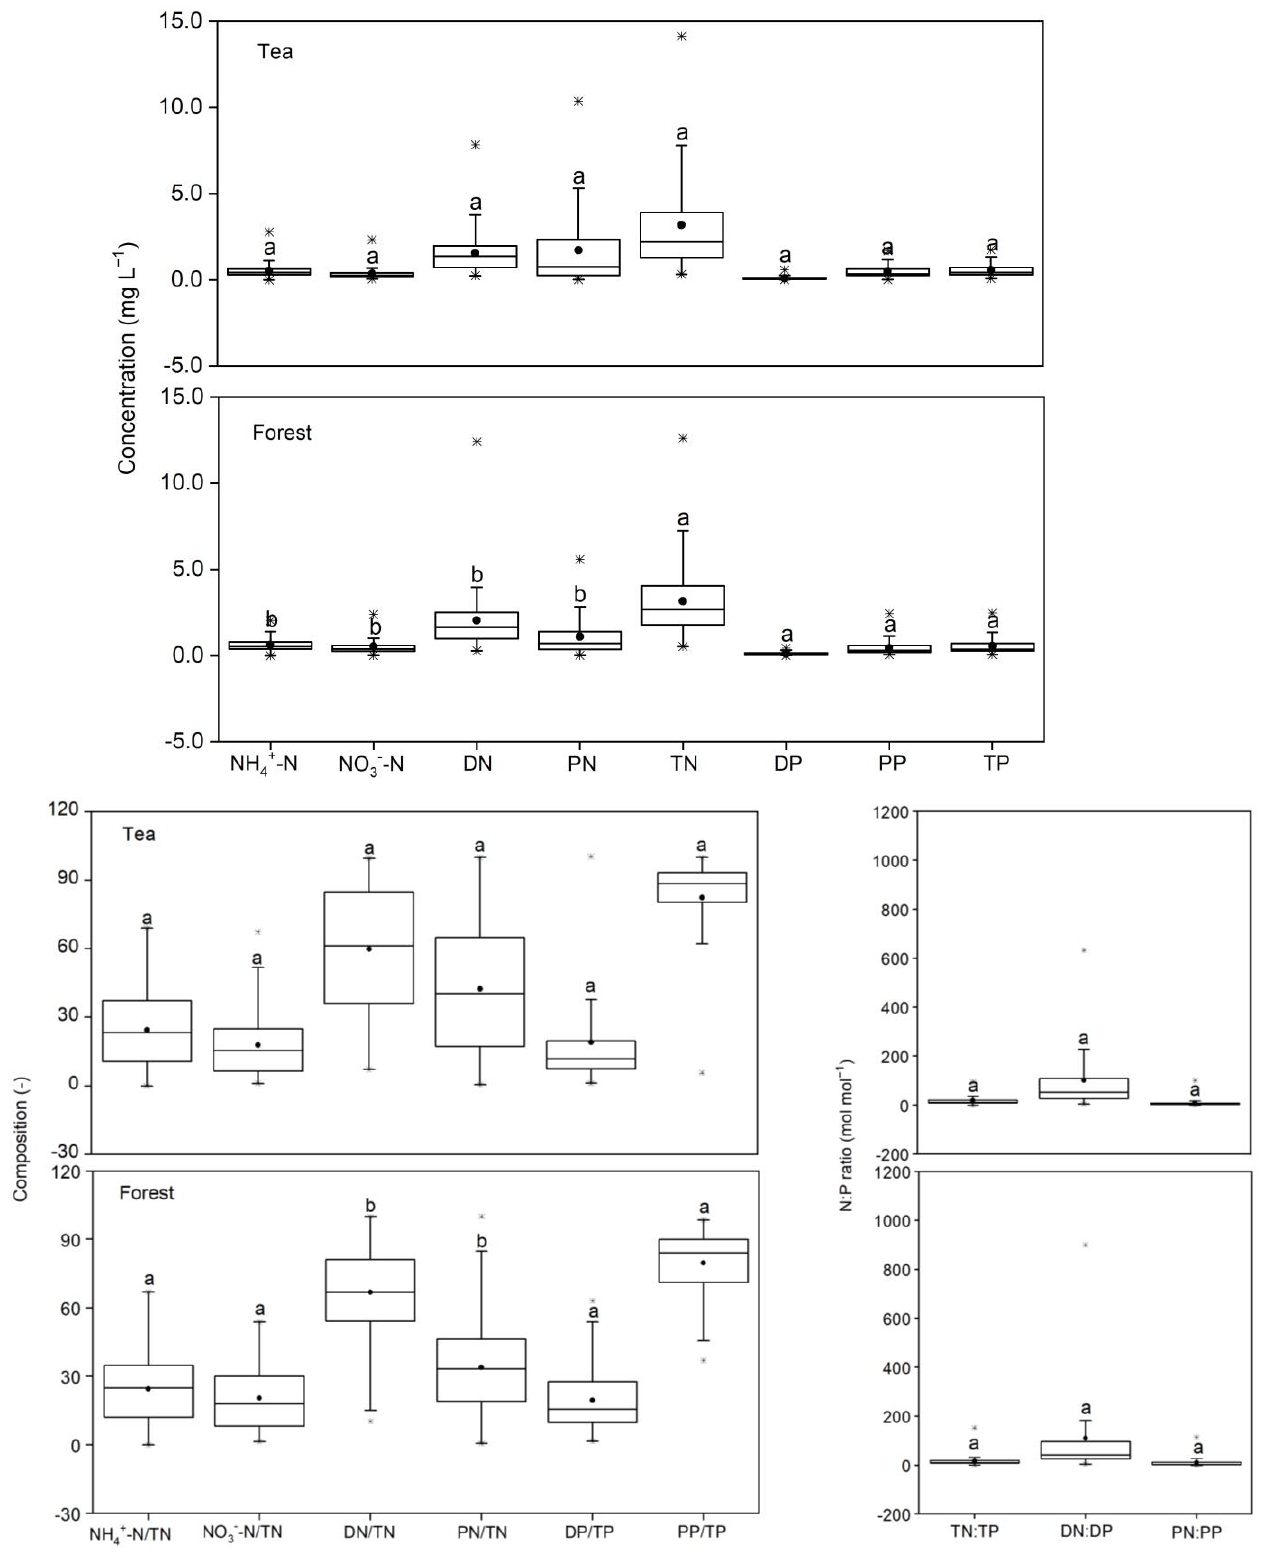
Figure 3. Mean and standard deviation (SD) of the nitrogen and phosphorus concentrations, chemical compositions, and molar ratios in the surface runoff in the tea and forest systems. Different letters indicate a significant difference between the tea and forest systems ( p < 0.05)